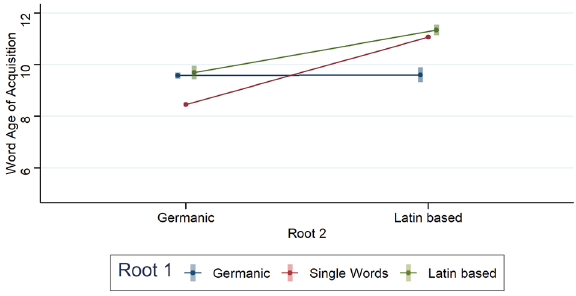
Fig. 1 Interaction between root 1 ( fi rst word) and root 2 (second word) in terms of origin. Single Germanic words are learned earlier than Latin-based words (red line). The same appears for compounds that start with a Latin- based item (green line). For compounds that start with a Germanic item, the AoA of the word does not change if the second word is Germanic or Latin-based.